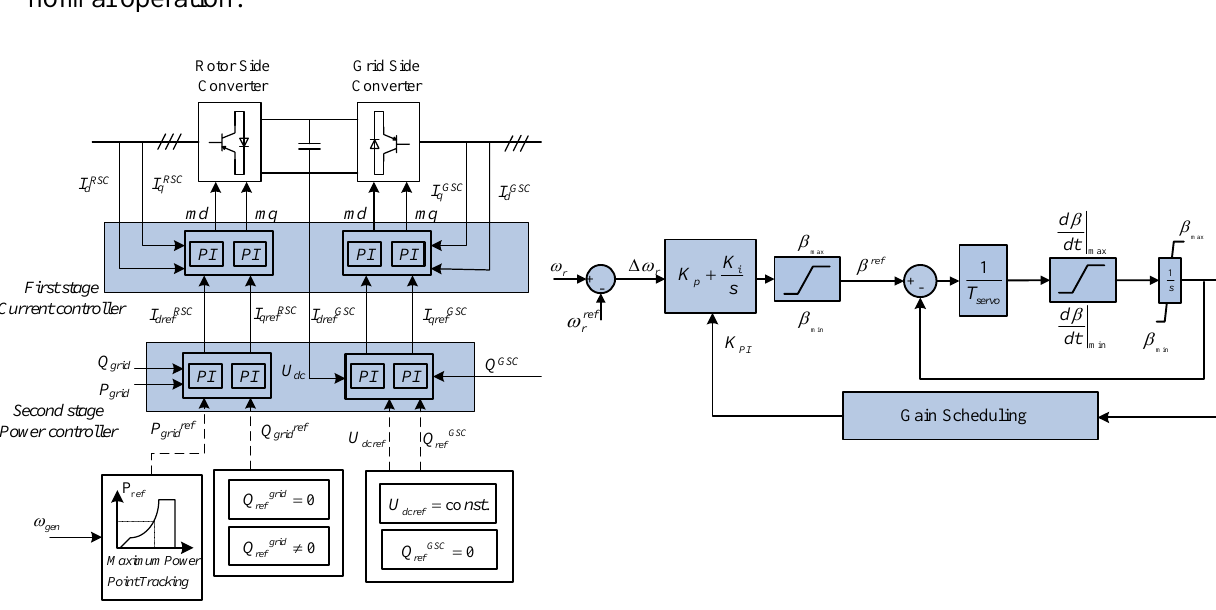
Figure 2. Converter control and pitch control system of the DFIG wind turbine for normal